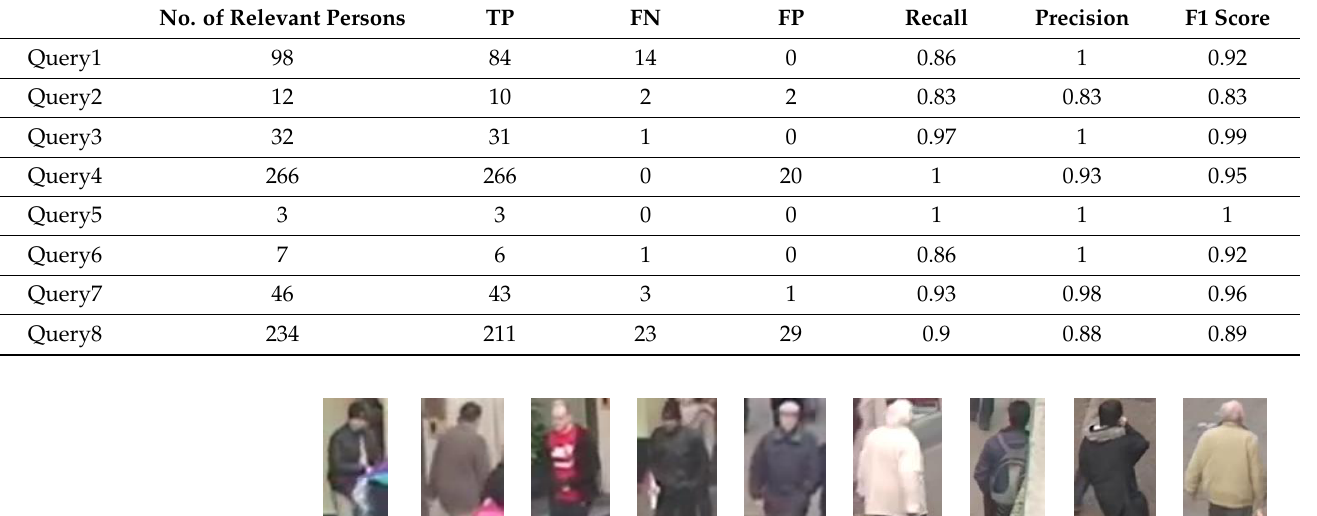
Table 2. Retrieval process performance evaluation.